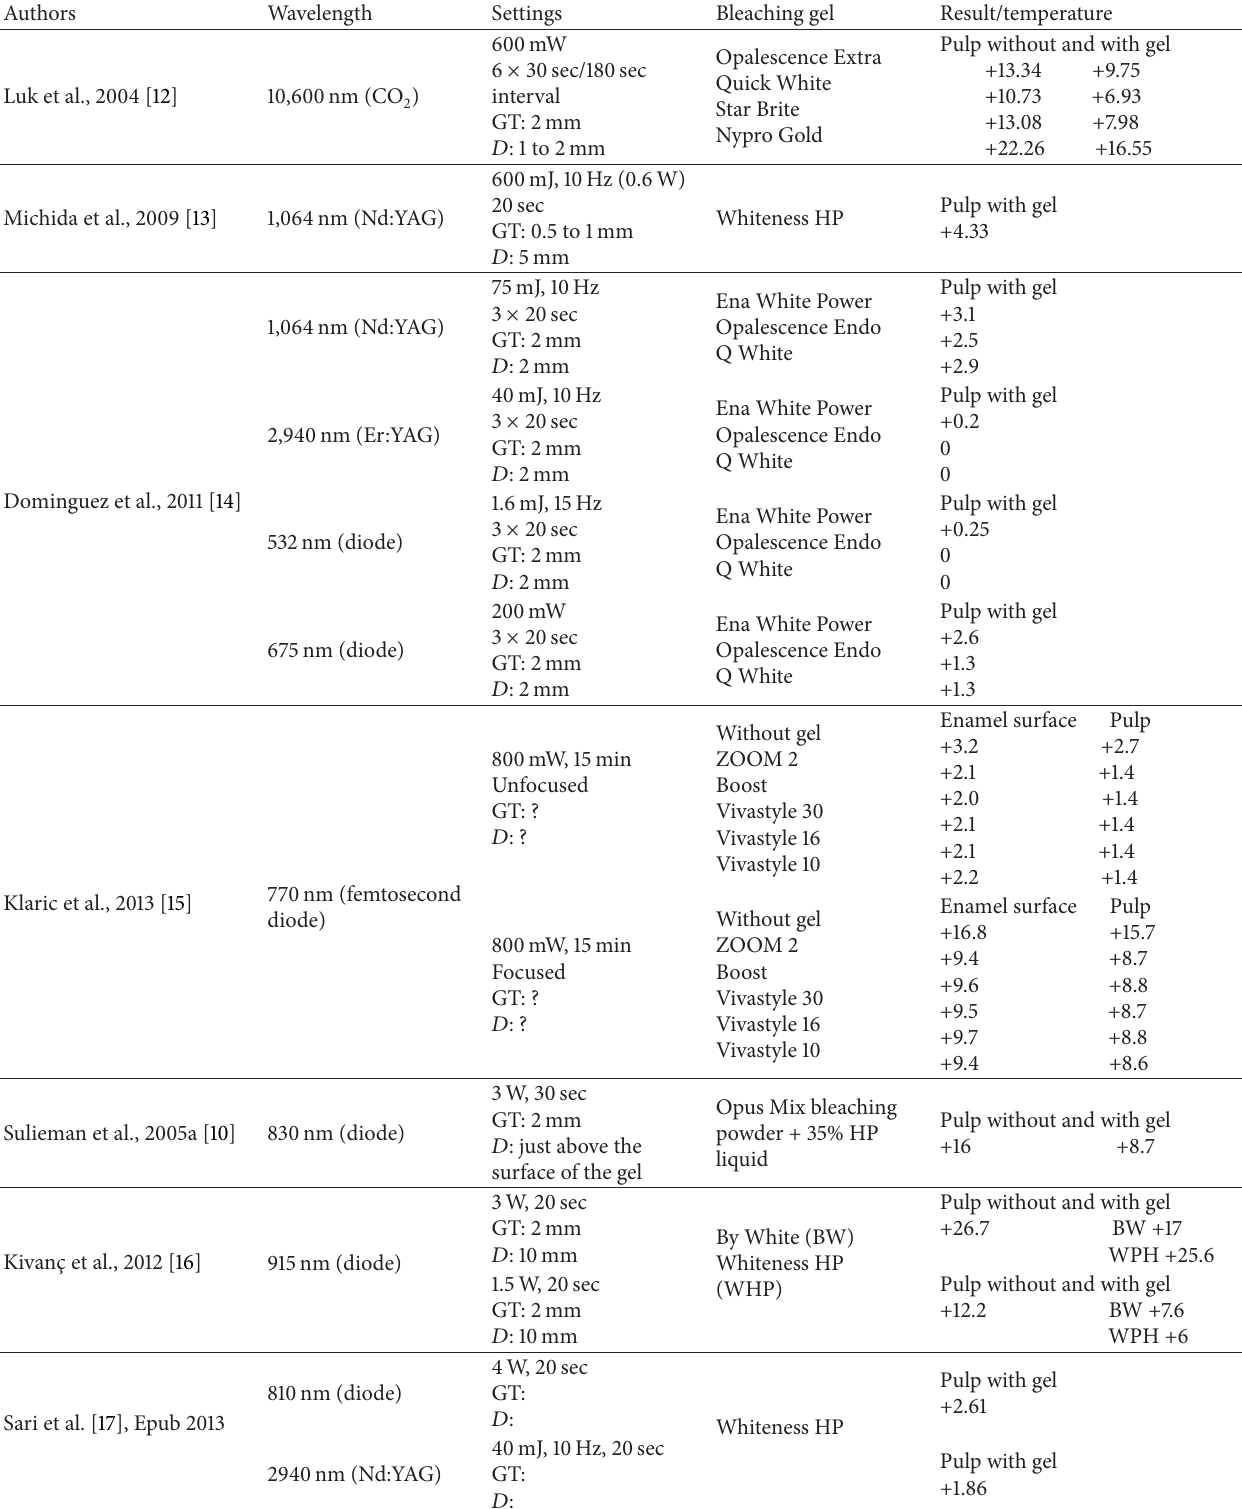
Table 1: Increase in temperature ( ∘ C) in the pulp (without or with gel application) after exposure to laser light.